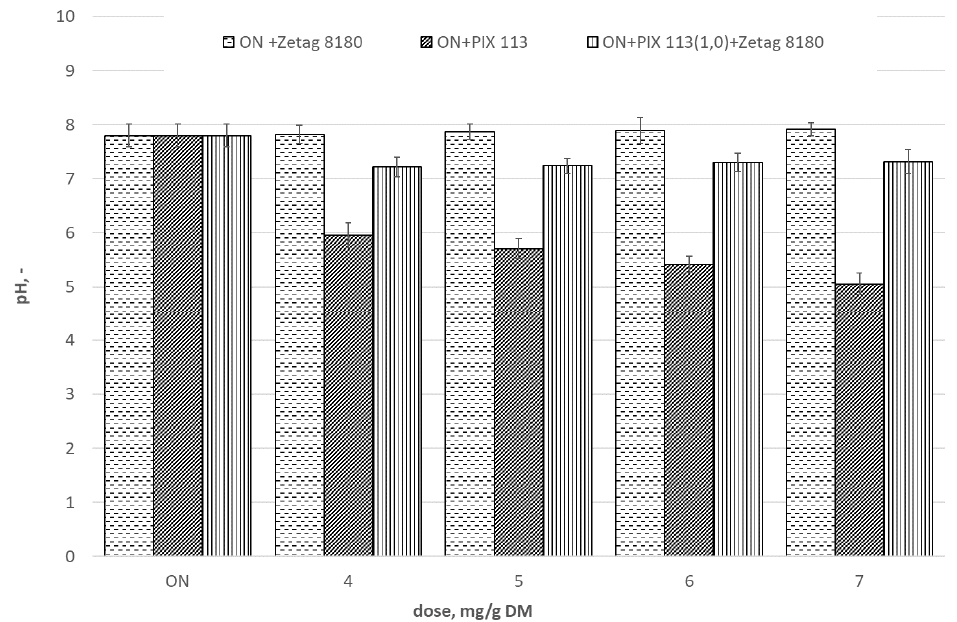
Figure 7. pH changes in filtrate after sludge dewatering. Sludge sonicated (A 1 = 15.25 µm) and prepared with selected chemical reagents.